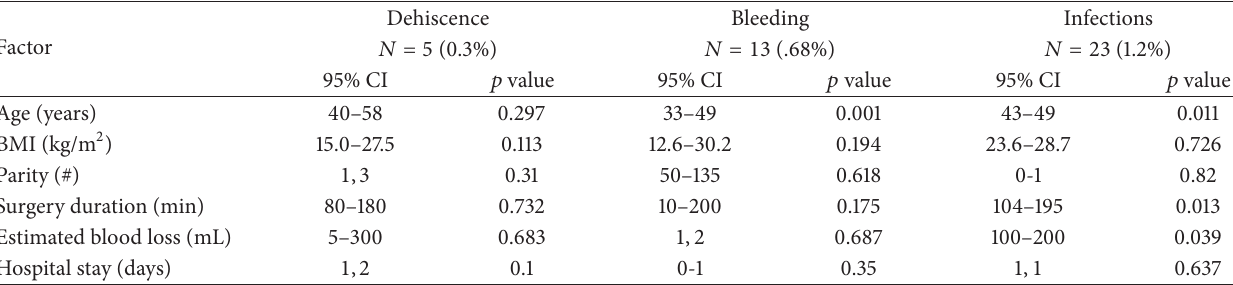
Table 3: Relationship between demographic factors and